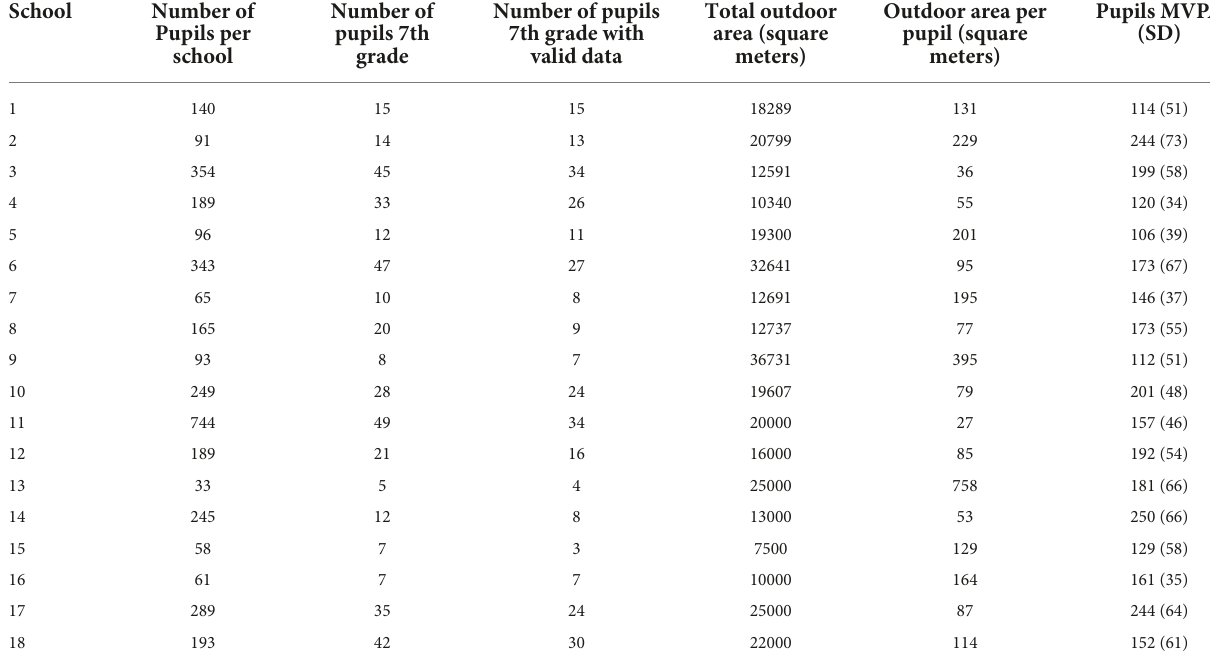
TABLE 1 Descriptive characteristics of the participating schools in relation to the number of pupils, outdoor area, and pupils’ MVPA.